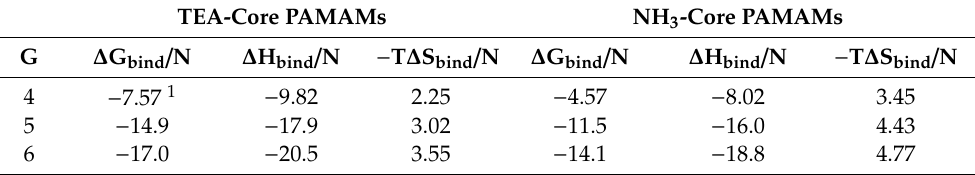
Table 1. In silico normalized free energy of binding ( ∆ G bind / N ) and its major components (binding enthalpy ∆ H bind / N and entropy variation –T ∆ S bind / N ) for G 4 –G 6 TEA-core and NH 3 -core PAMAMs in complex with heat shock protein 27 (Hsp27) small interfering RNA (siRNA) at pH 7.4 and 0.15 M NaCl. The normalization factor N is the generation-specific total number of charged dendrimer terminal groups ( N ). All values are expressed in kcal / mol 1 . Adapted from [35] with permission of John Wiley and